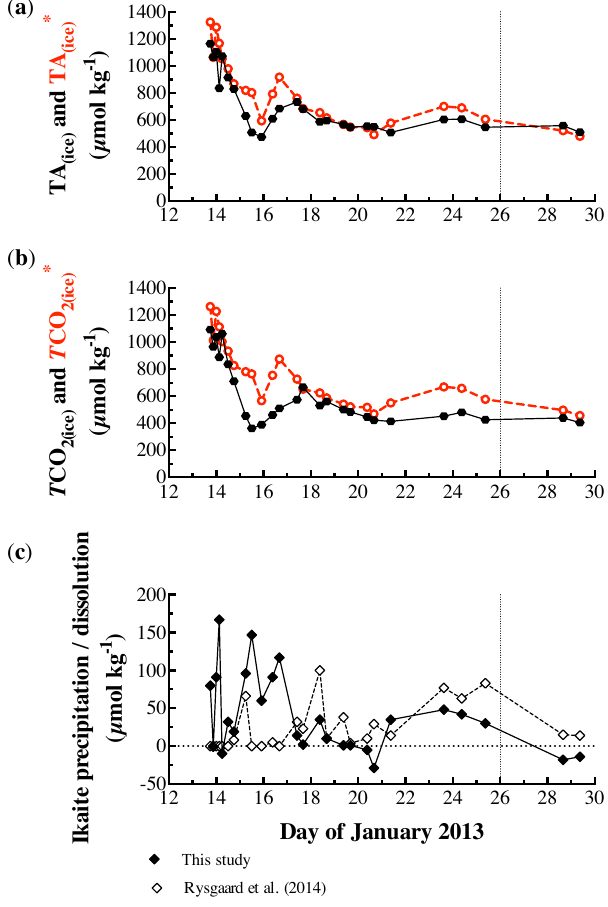
Figure 7. Evolution of (a) TA (ice) averaged throughout the ice thickness on each sampling day (black dots) and TA ∗ red line) (µmolkg − 1 ) and (b) TCO 2(ice) averaged throughout the ice thickness on each sampling day (black diamonds) and TCO ∗ (dashed red line) (µmolkg − 1 ). (c) Estimation of the ikaite pre- cipitation/dissolution from half of the difference between TA ∗ and TA (ice) (µmolkg − 1 ) (black diamonds) compared to the average amount of ikaite precipitated throughout the ice thickness for each sampling day from Rysgaard et al. (2014) (white dots). The vertical black dotted line on 26 January marks when the heat was turned back